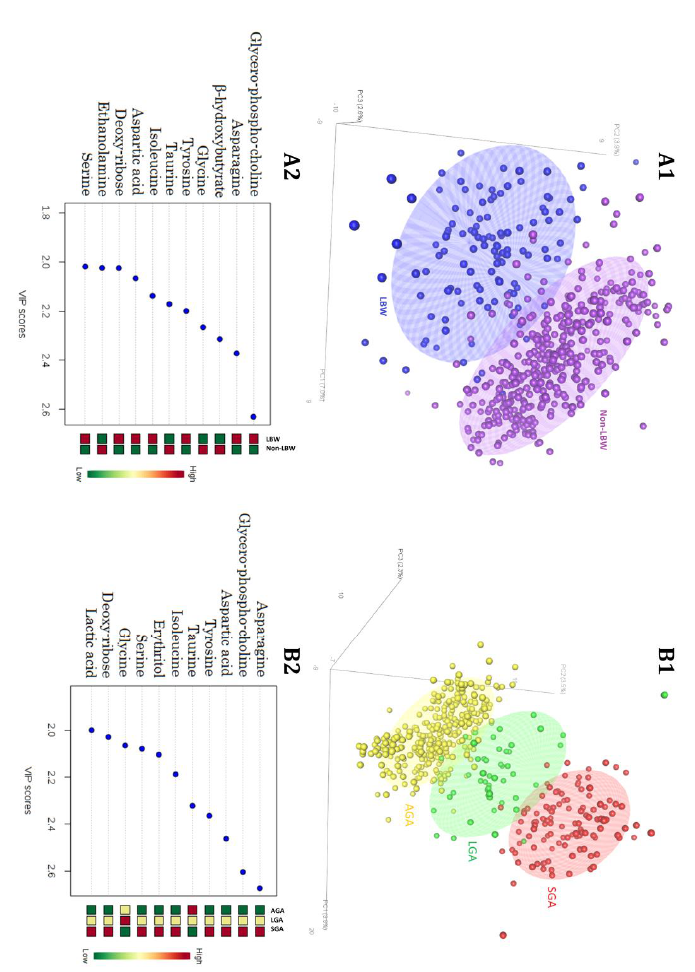
Figure 1. Classification models: ( A1 ). Two class (LBW vs. non-LBW) PLS-DA score plot. ( A2 ). VIP metabolites heat-map selected by the dichotomic classification. ( B1 ) Three class (SGA, AGA, and LGA) PLS-DA score plot. ( B2 ) VIP metabolites heat-map selected by the three-class classification. Abbreviations: LBW: low birth weight; PLS-DA: partial least square discriminant analysis; VIP: var-